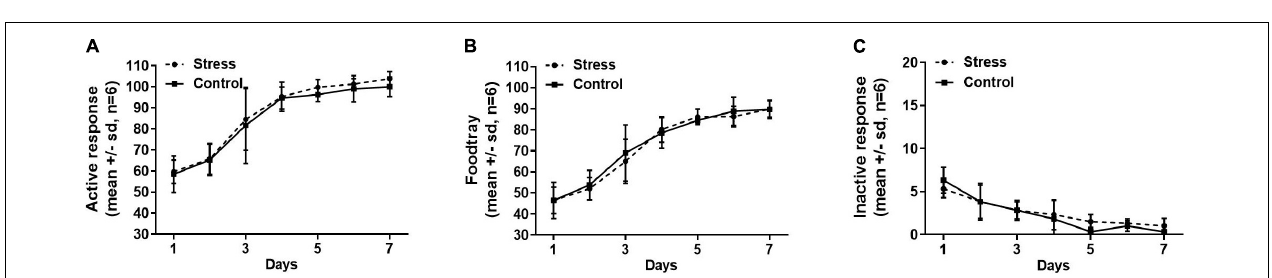
FIGURE 4 | The numbers of active nose-poke responses (A) , food tray (B) , and inactive nose-poke responses (C) were compared between the stress group and the control group, indicating that neither the active nose-poke responses ( p = 0.88), food tray ( p = 0.76), nor the number of inactive nose-poke responses ( p = 0.62) was affected by the tail clip stressful stimulation. The data were analyzed with repeated measures of ANOVA. SD, standard